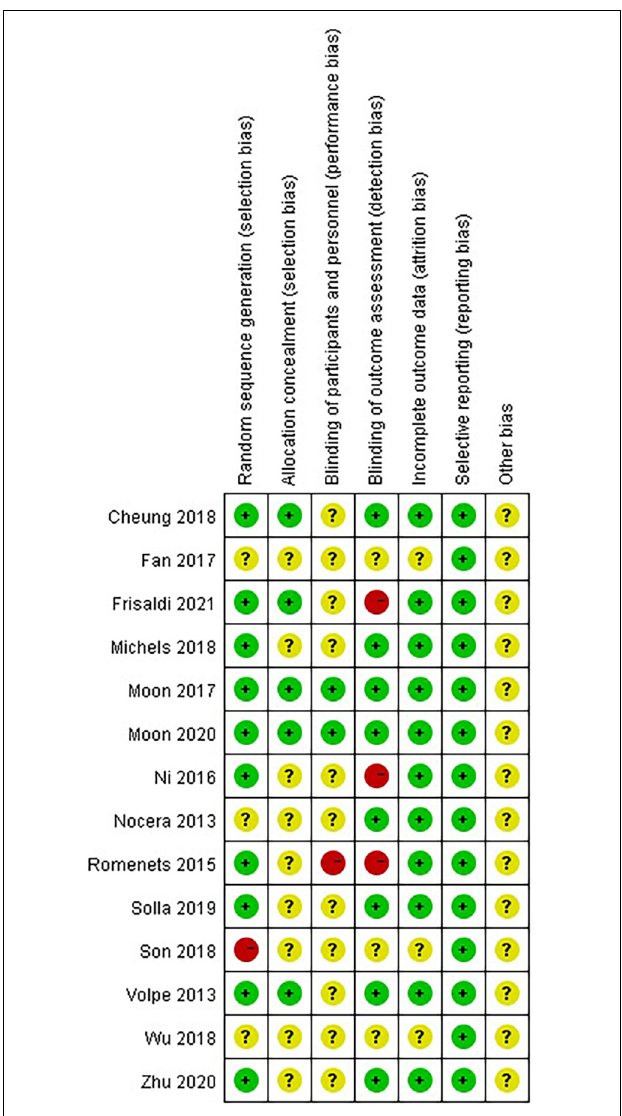
FIGURE 2 | Risk of bias summary: review authors’ judgments about each risk of bias item for each included